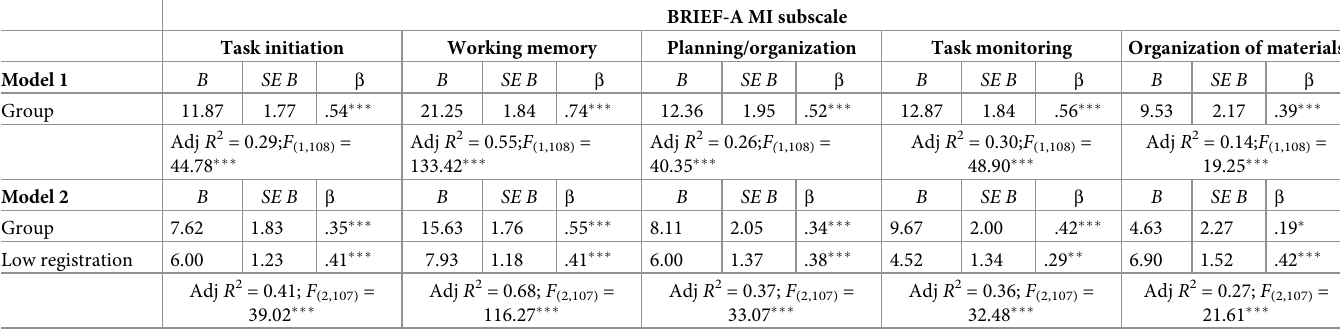
Table 4. Predicting each specific BRIEF-A MI subscale score from AASP subscale scores above group